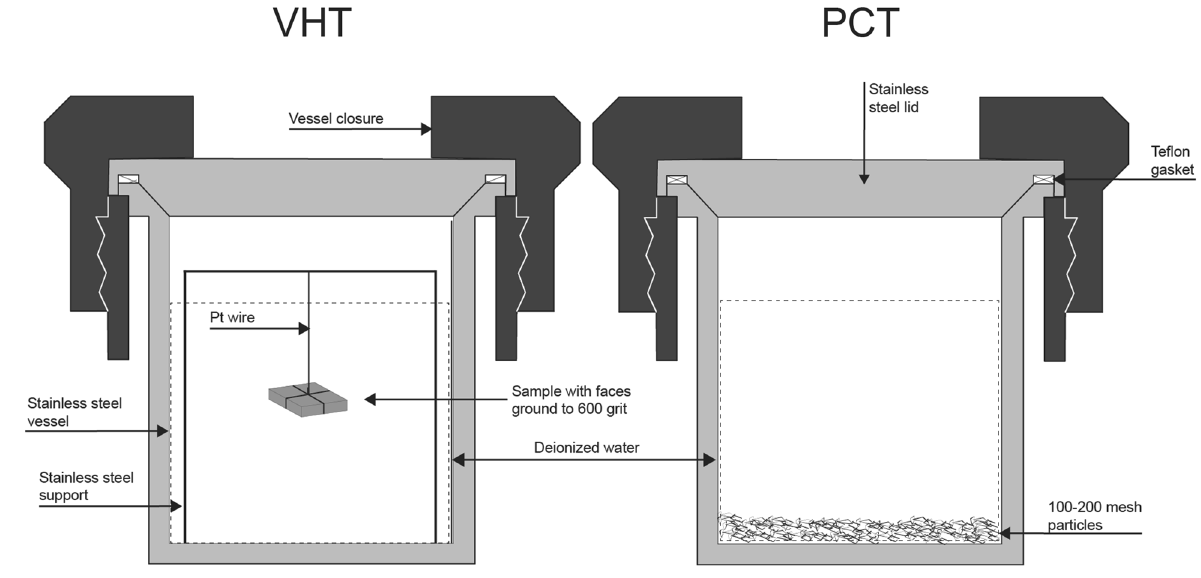
Figure 2. Schematic of the VHT and PCT sample set